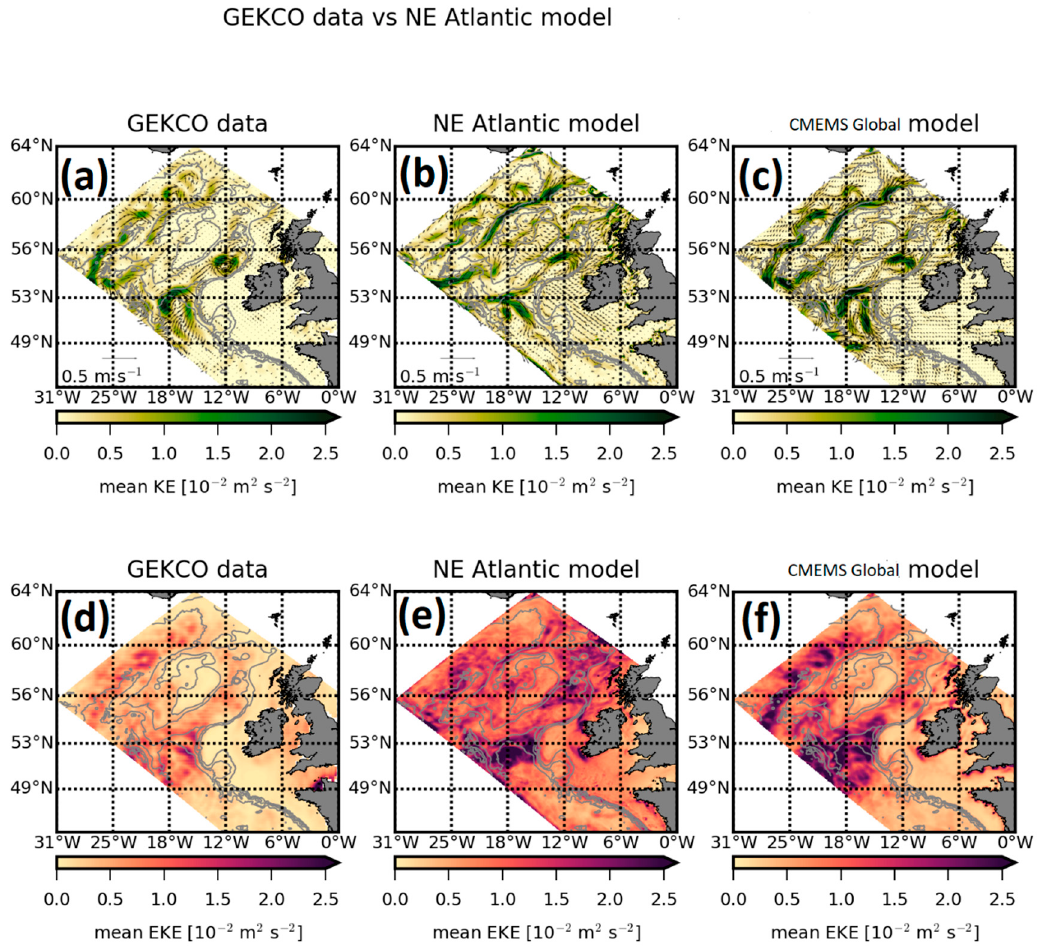
Figure 9. Mean Kinetic Energy fields combined with surface current from ( a ) GEKCO data, ( b ) NEA_ROMS model, ( c ) CMEMS global model, and the mean EKE from ( d ) GEKCO data, ( e ) NEA_ROMS model, and ( f ) CMEMS global